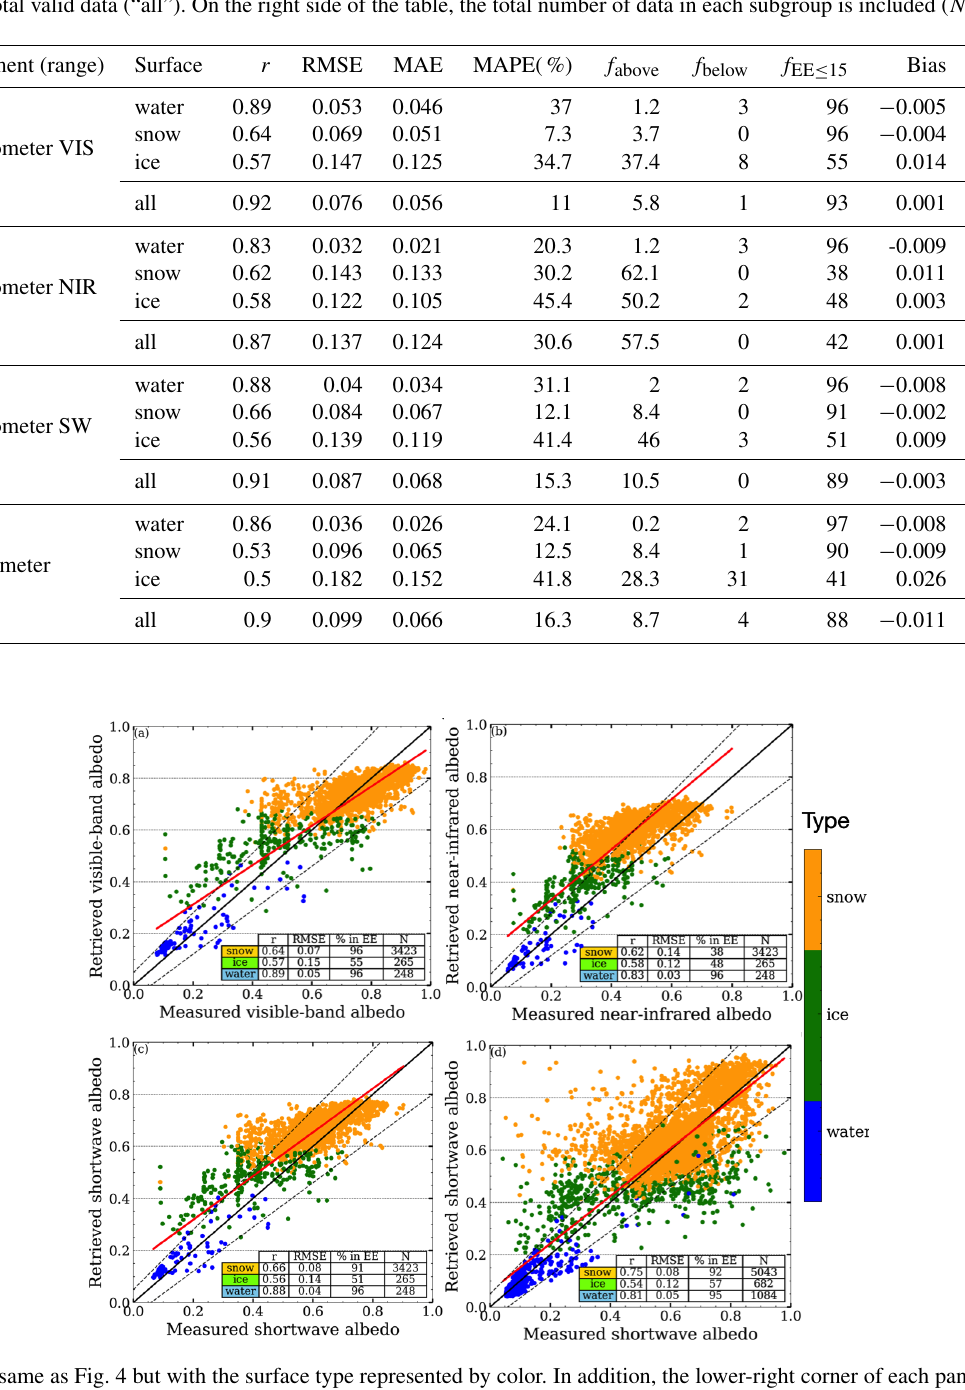
Table B2. Summary of the evaluation results for a time constraint with a loose value ( δ t ≤ 5h). The data were divided into four categories: three broadband albedos determined by the albedometer’s spectral range and a single broadband shortwave albedo determined by the pyra- nometer’s range. Three subcategories have been identified within each category: snow-covered sea ice (abbreviated as “snow” in the table), bare sea ice (“ice”), and open water (“water”). Pearson r coefficient ( r ), root-mean-square error (RMSE), mean absolute error (MAE), mean absolute percentage error (MAPE), f above , f EE ≤ 15 , f below , and bias are used to evaluate the retrieval in the subcategories (snow, ice, and water) and the total valid data (“all”). On the right side of the table, the total number of data in each subgroup is included ( N ).